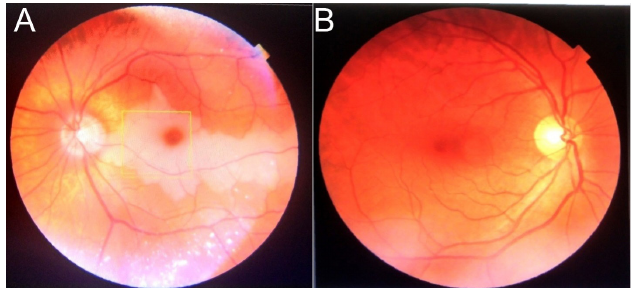
Figure 1. A- Left fundus showing pale retina in the posterior pole along with cherry red spot. B-Normal right fundus.